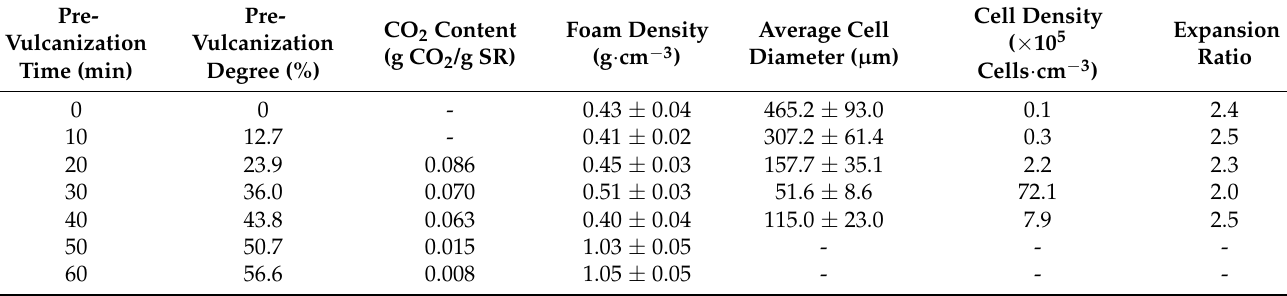
Table 1. Parameters of foamed samples with different pre-vulcanization